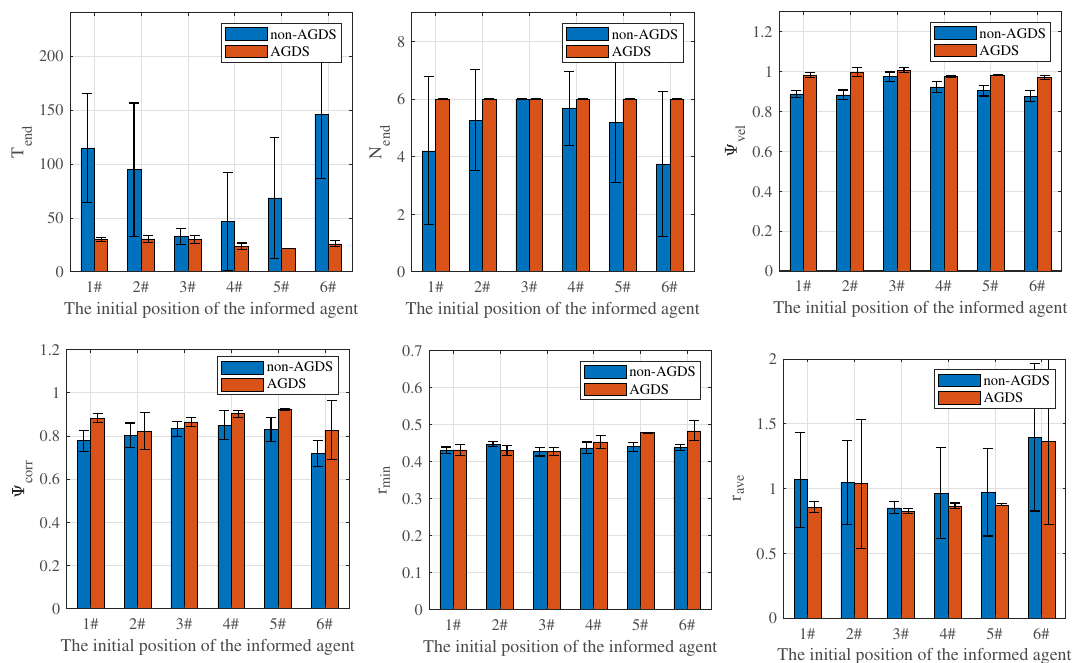
Fig. 12 Aggregated results (average and standard deviation) of 15 stochastic simulations of the different initial positions of the informed agentforthenon-AGDSandAGDSflockingalgorithm.Therepresented metricsarethetraversaltime T end ,thenormalizedswarmspeed (cid:4) vel ,the